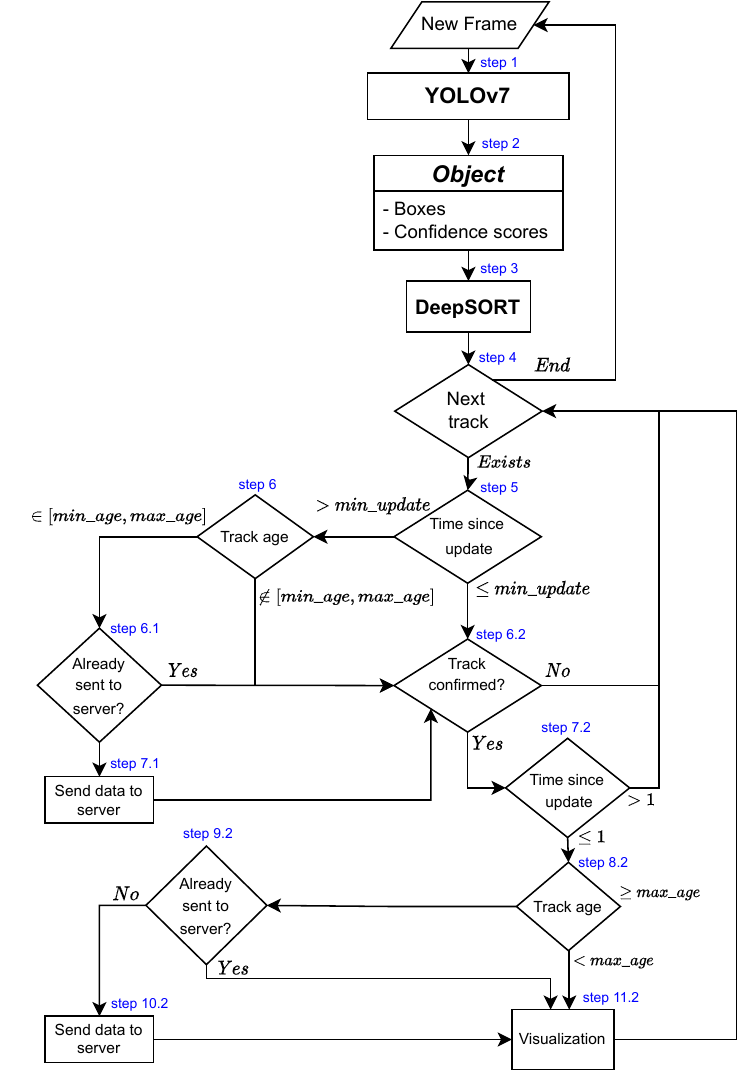
Figure 4. The AERO model architecture of the AI module. First, the system checks if the track has not been matched with a detected bounding box for more than a predefined number of consecutive frames (default value of 10). If so, the system assumes that the object is no longer in the camera’s field of view. Next, the system checks if the track’s age (number of frames in which the same object has been detected) is within a predefined interval (default value of [2, 40]). A low value indicates that the track is unreliable, whereas a high value means that the object information has already been sent to the server. The default values of the minimum number of consecutive frames and the track’s age interval were fixed empirically after a series of preliminary tests. In all cases, the system checks if the current track has been confirmed by being observed in the required minimum number of consecutive frames (default value of 3) and has not been deleted due to missed detections. If the track is confirmed or has been matched with detected bounding boxes in the current or previous frames, the system checks its tracking age. If the age is equal to or greater than the maximum allowed age, the system sends its information to the server if it has not yet been sent. Finally, the system can optionally visualize the object’s bounding box and information using the current attributes of the track